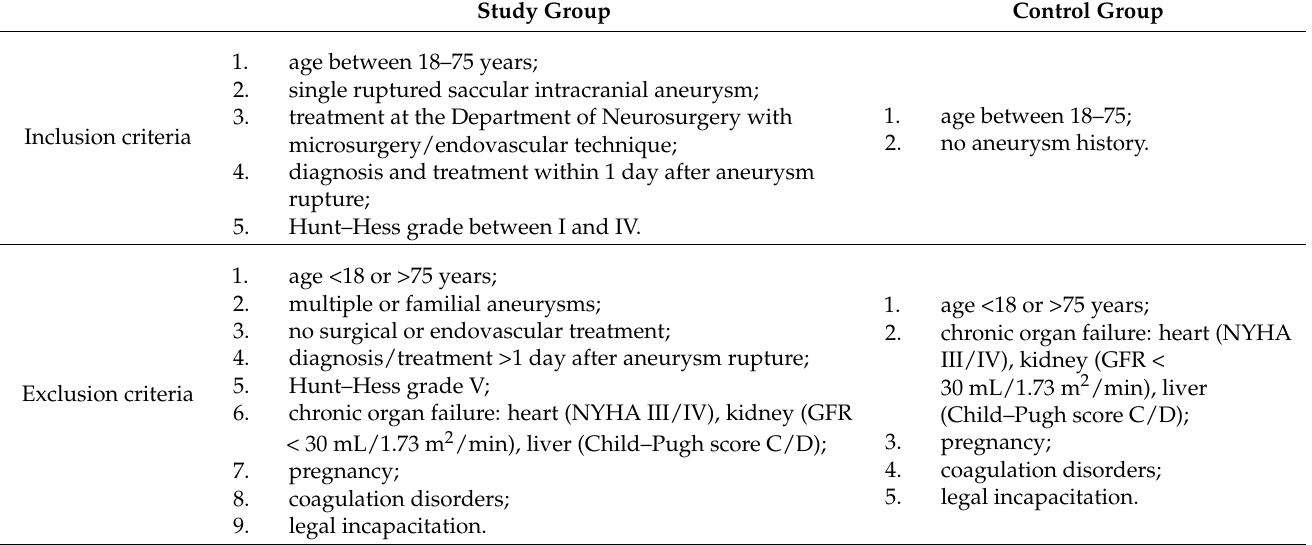
Table 1. Inclusion and exclusion